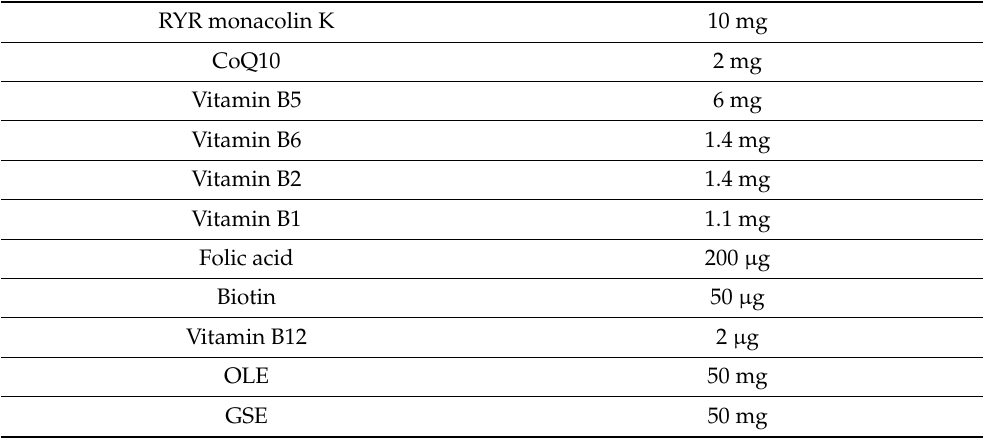
Table 1. Chemical composition of the RYR preparation daily